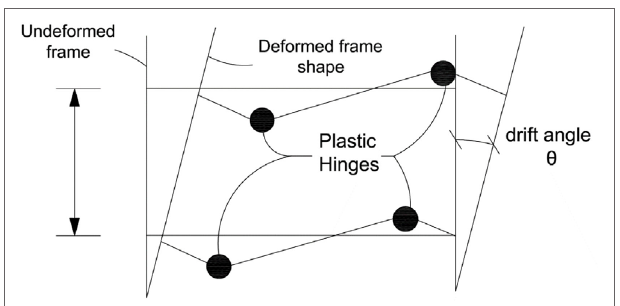
Figure 1 | Ideal location of plastic hinge formation in beams (adapted from Sarno and Elnashai, 2002) reproduced with permission from the copyright